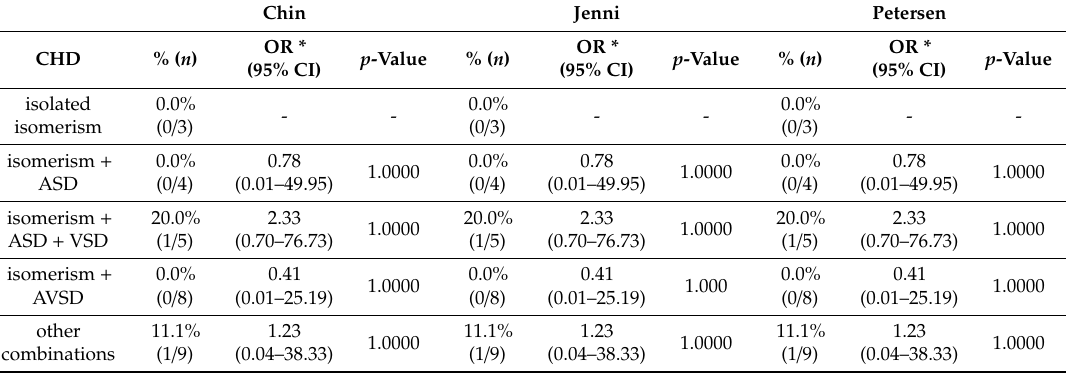
Table 7. Percentage of hearts presenting LVNC in isomerism according to Chin, Jenni, and Petersen (apex).